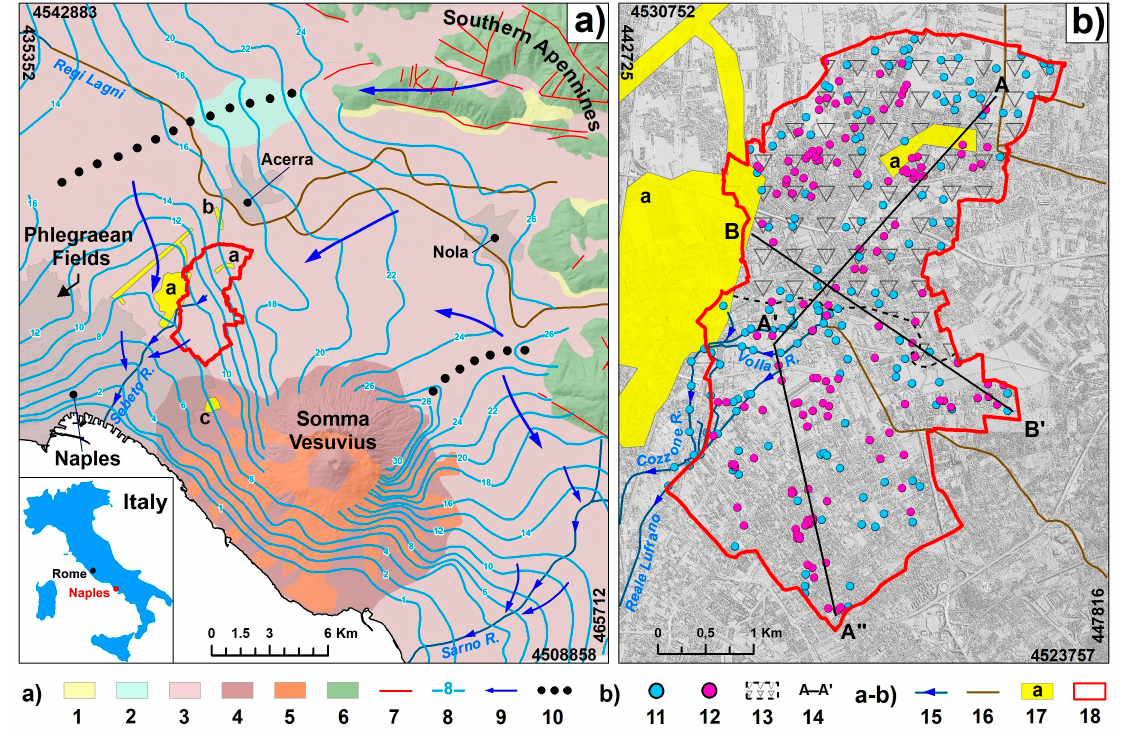
Figure 1. ( a ) Hydrogeological map of the eastern plain of Naples [55 modified] and ( b ) study area. Legend: (1) epiclastic continental complex; (2) travertines complex; (3) ash fall pyroclastic complex; (4) ash flow pyroclastic complex; (5) lava complex; (6) carbonate complex; (7) normal fault; (8) piezometric contour line (m a.s.l.); (9) groundwater flow direction; (10) groundwater divide; (11) wells and piezometers considered for measures of piezometric levels; (12) borehole; (13) sector with buried CI; (14) trace of hydrogeological cross-section (Figure 2); (15) rivers connected with groundwater circulation; (16) rivers with negligible or null interactions with groundwater circulation due to ephemeral regime or waterproofing of riverbed by cementing; (17) Lufrano’s well field of (a), Acerra (b) and Ponticelli (c); and (18) study